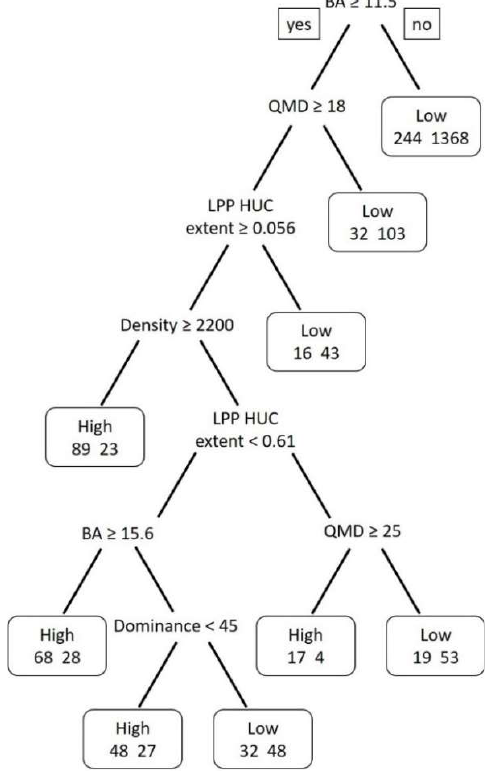
Figure A2. Parsimonious classification tree; misclassification rate 18%. In each box, the left value is the number of incorrectly classified subwatersheds and the right value is the number of correctly classified subwatersheds. Classification tree 1 in Table A1. See Table 1 for variable descriptions.